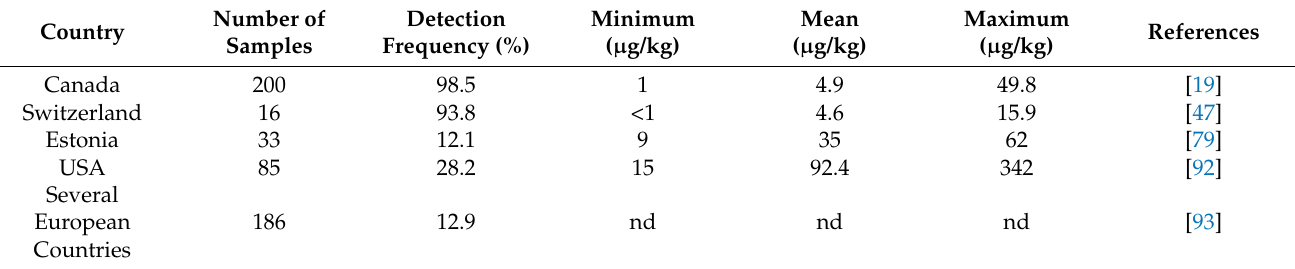
Table 4. Occurrence of glyphosate in